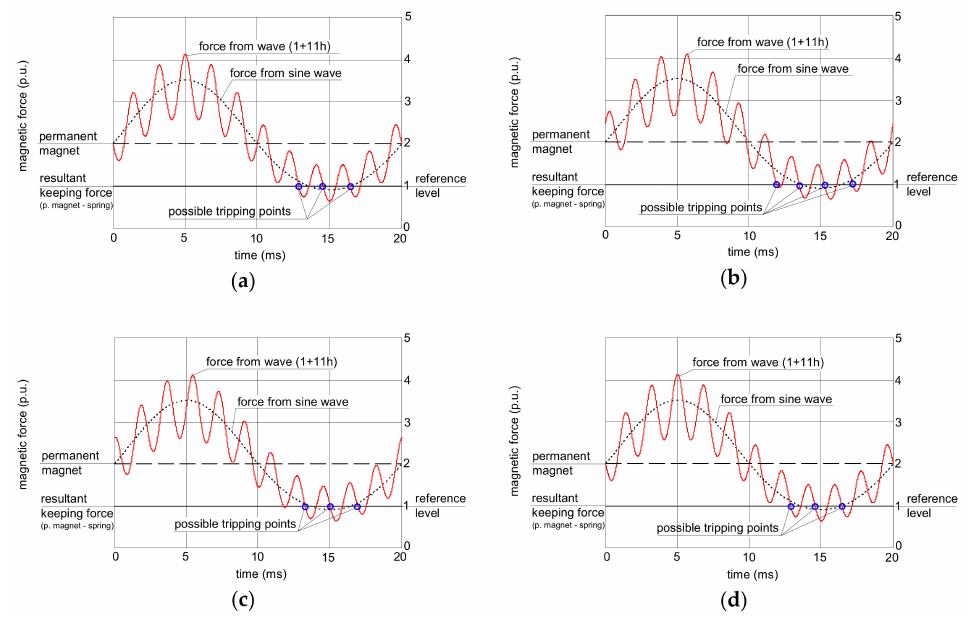
Figure 5. Interaction between forces in the electromechanical relay of the RCD for earth fault current waveforms comprising the fundamental and 50% of the 11 th harmonic. The phase angle of the 11 th harmonic: ( a ) 0 ◦ ; ( b ) 45 ◦ ; ( c ) 90 ◦ ; ( d ) 180 ◦ .